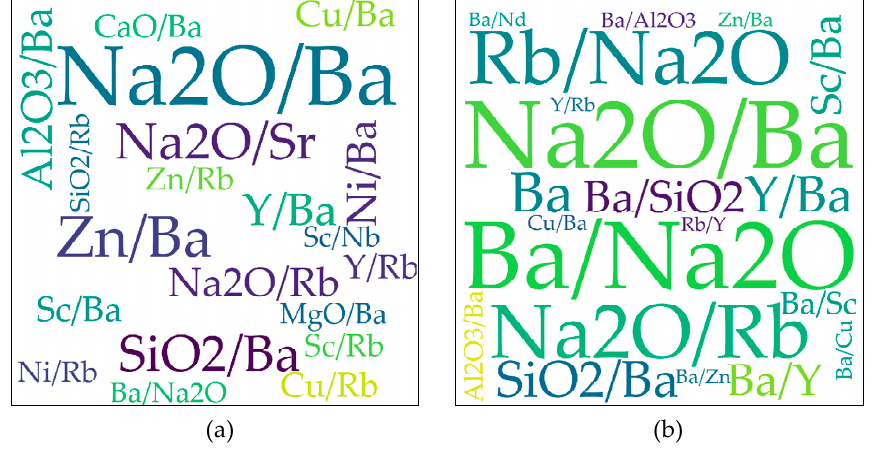
Figure 18. Word clouds of the top 20 important elements (or element ratios) for MORG and non- MORG discrimination diagrams. ( a ) is for linear coordinates; ( b ) is for logarithmic coordinates.